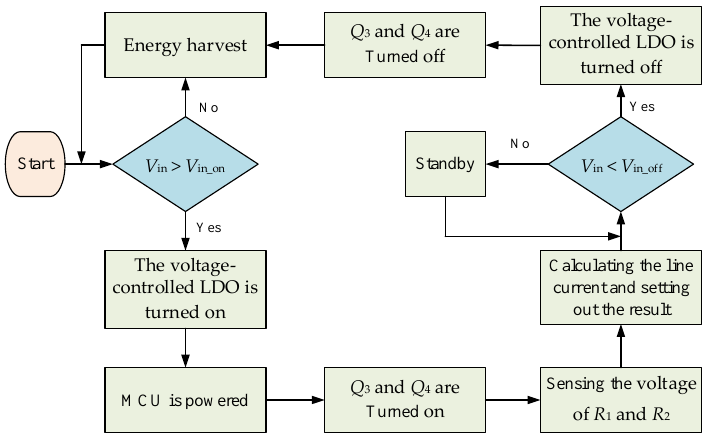
Figure 10. The workflow of the system.